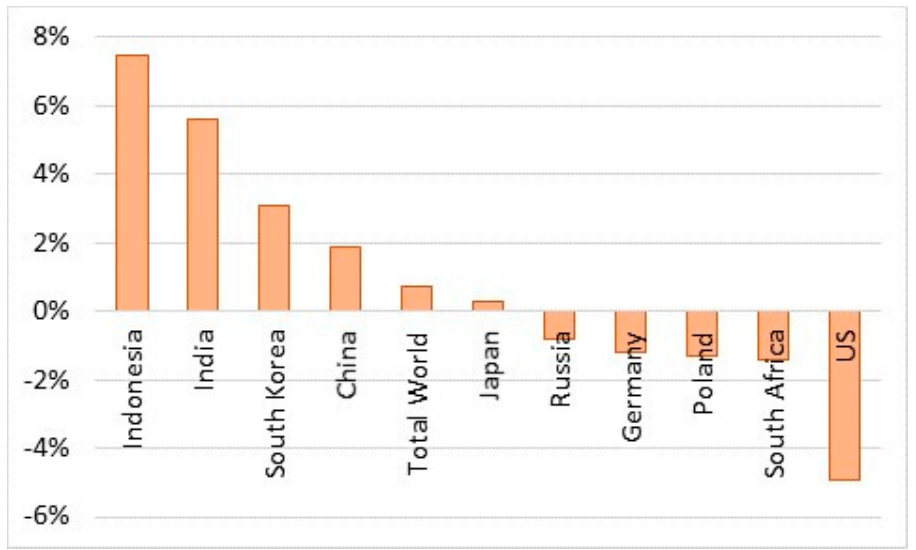
Figure 1. Annual coal consumption growth of the top ten coal consumers (2008–2017), adapted from: BP [27].